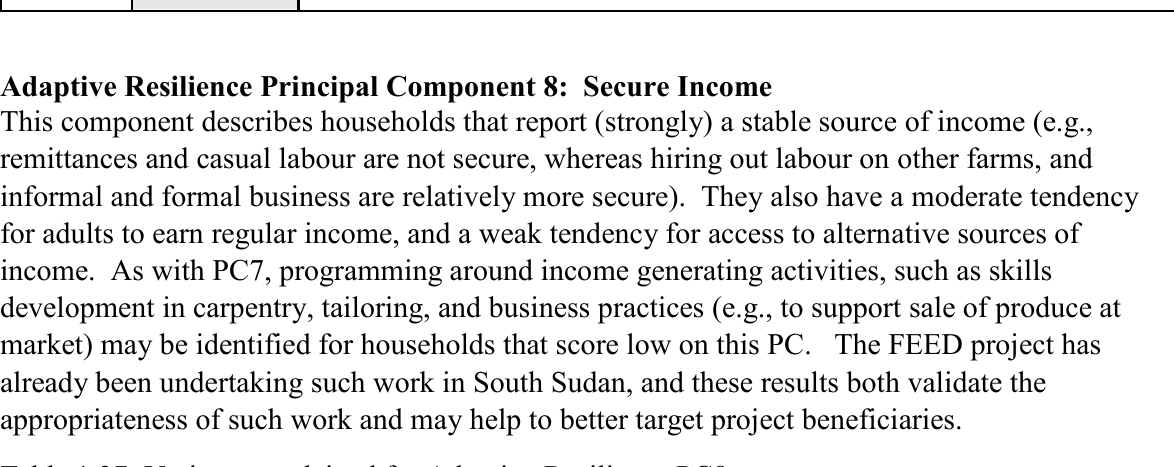
Table 1.37: Variance explained for Adaptive Resilience PC8